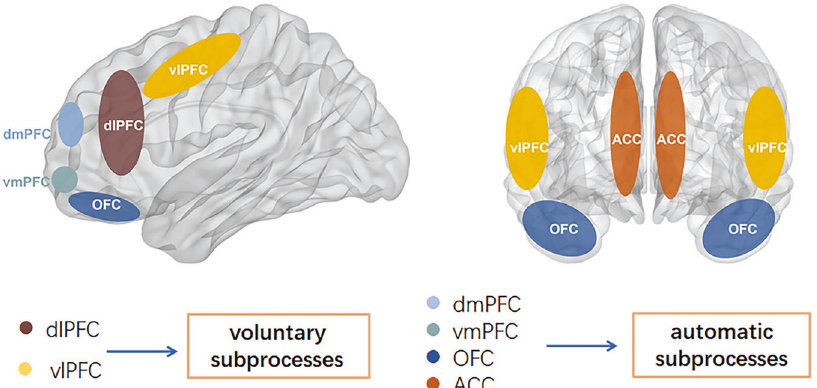
Fig. 1 Voluntary subprocesses and automatic subprocesses. The lateral prefrontal cortical regions (dlPFC and vlPFC), which develop relatively late and are involved in higher executive functions may subserve voluntary subprocesses. The automatic subprocess includes the area of dmPFC, vmPFC, OFC, ACC, and are involved especially in the control of emotional behaviors. dlPFC dorsolateral prefrontal cortex, vlPFC ventrolateral prefrontal cortex, dmPFC dorsomedial prefrontal cortex, vmPFC ventromedial prefrontal cortex, OFC orbitofrontal cortex, ACC anterior cingulate